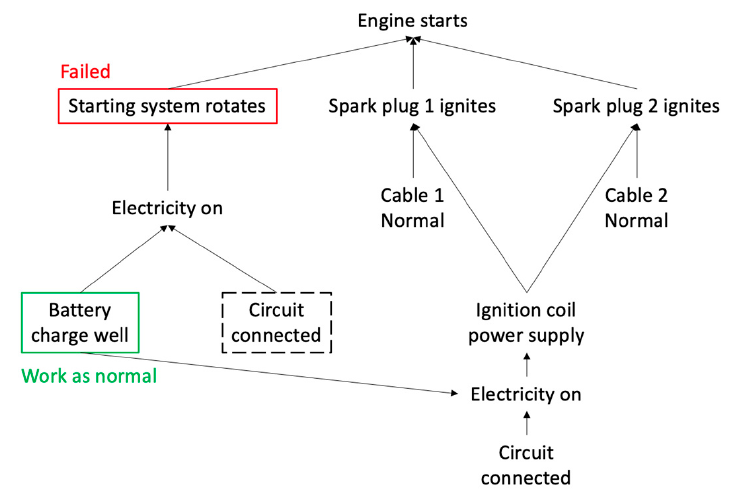
Figure 9. A simple case of reasoning.